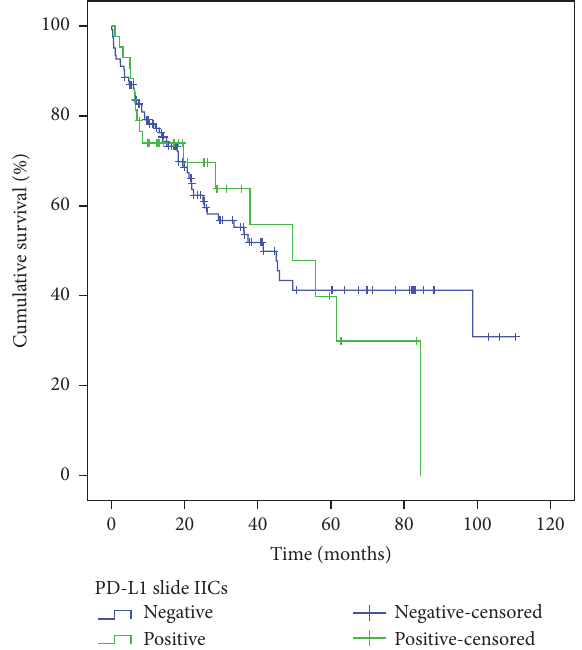
Figure 5: Overall survival according to PD-L1 positivity in IICs. x - axis: time after diagnosis in months. y -axis: percentage of patients alive (total of 177